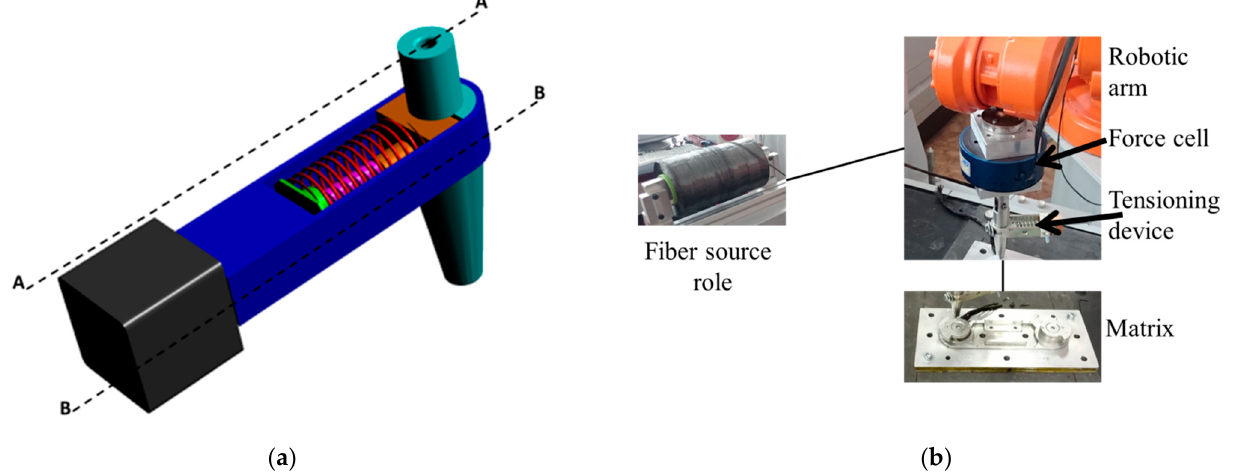
Figure 9. ( a ) Automatic fiber tensioning tool; ( b ) Real system implementation.